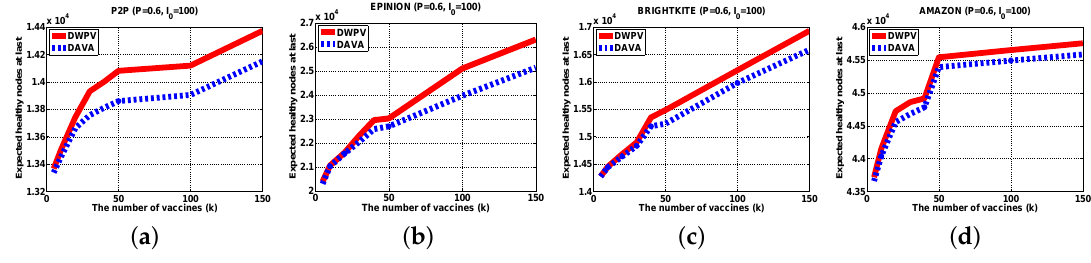
Figure 7. Experiments Results ( P = 0.6, I 0 = 100 ) . ( a ) P2P; ( b ) EPINION; ( c ) BRIGHTKITE; ( d ) AMAZON.